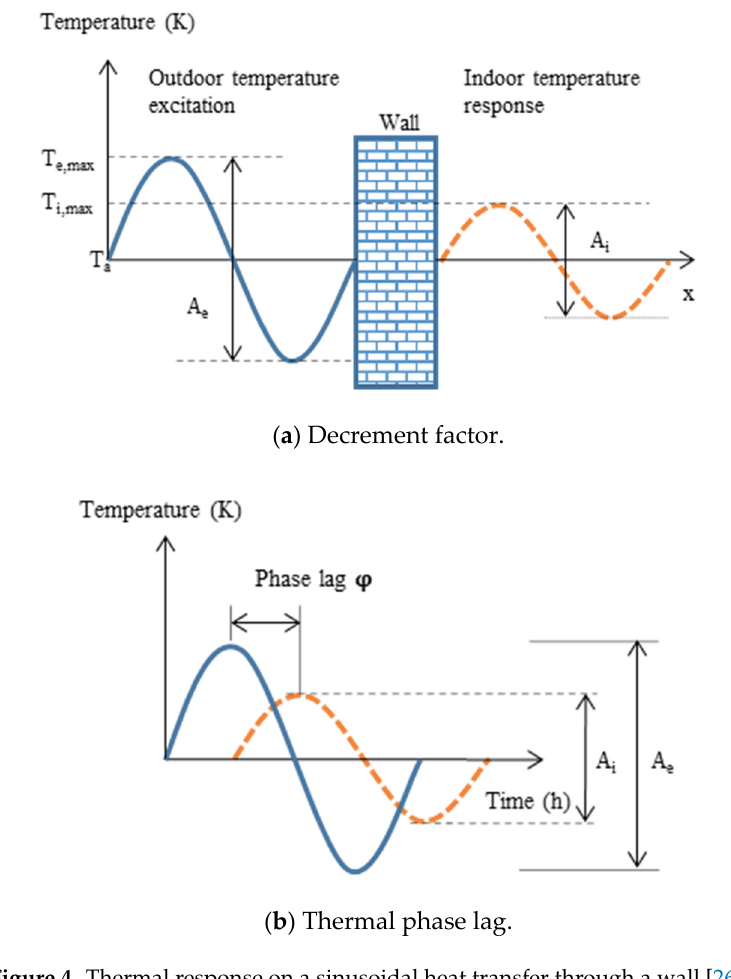
Figure 4. Thermal response on a sinusoidal heat transfer through a wall [26].